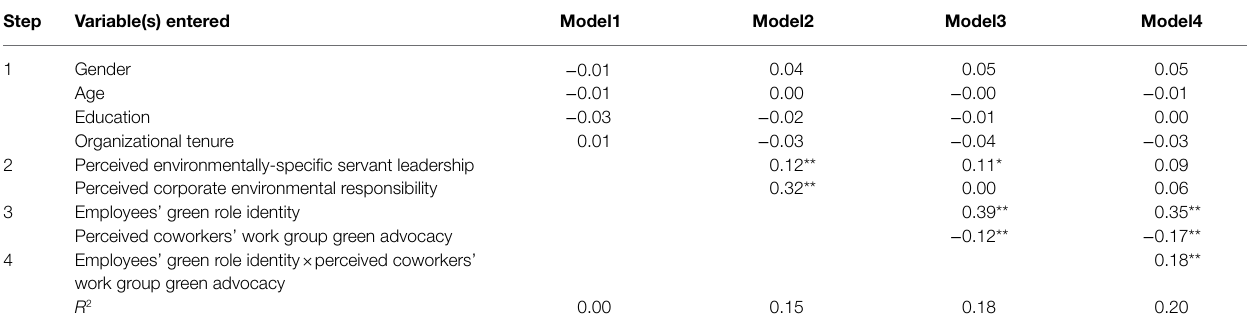
TABLE 5 | Results of moderated multiple regression analysis for employees’ workplace environmentally friendly behavior.